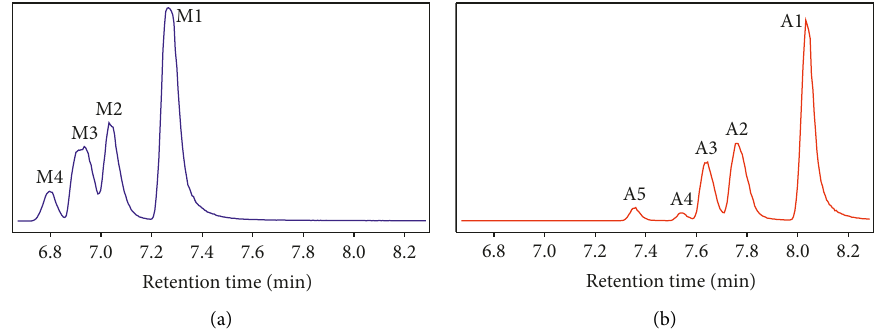
Figure 1: Total ion chromatograms of an ECF PFHxS technical product showing the impacts of organic reagents in the mobile phase on isomeric separation: (a): ammonium acetate (pH 4.0): methanol; (b): ammonium acetate (pH 4.0): acetonitrile.